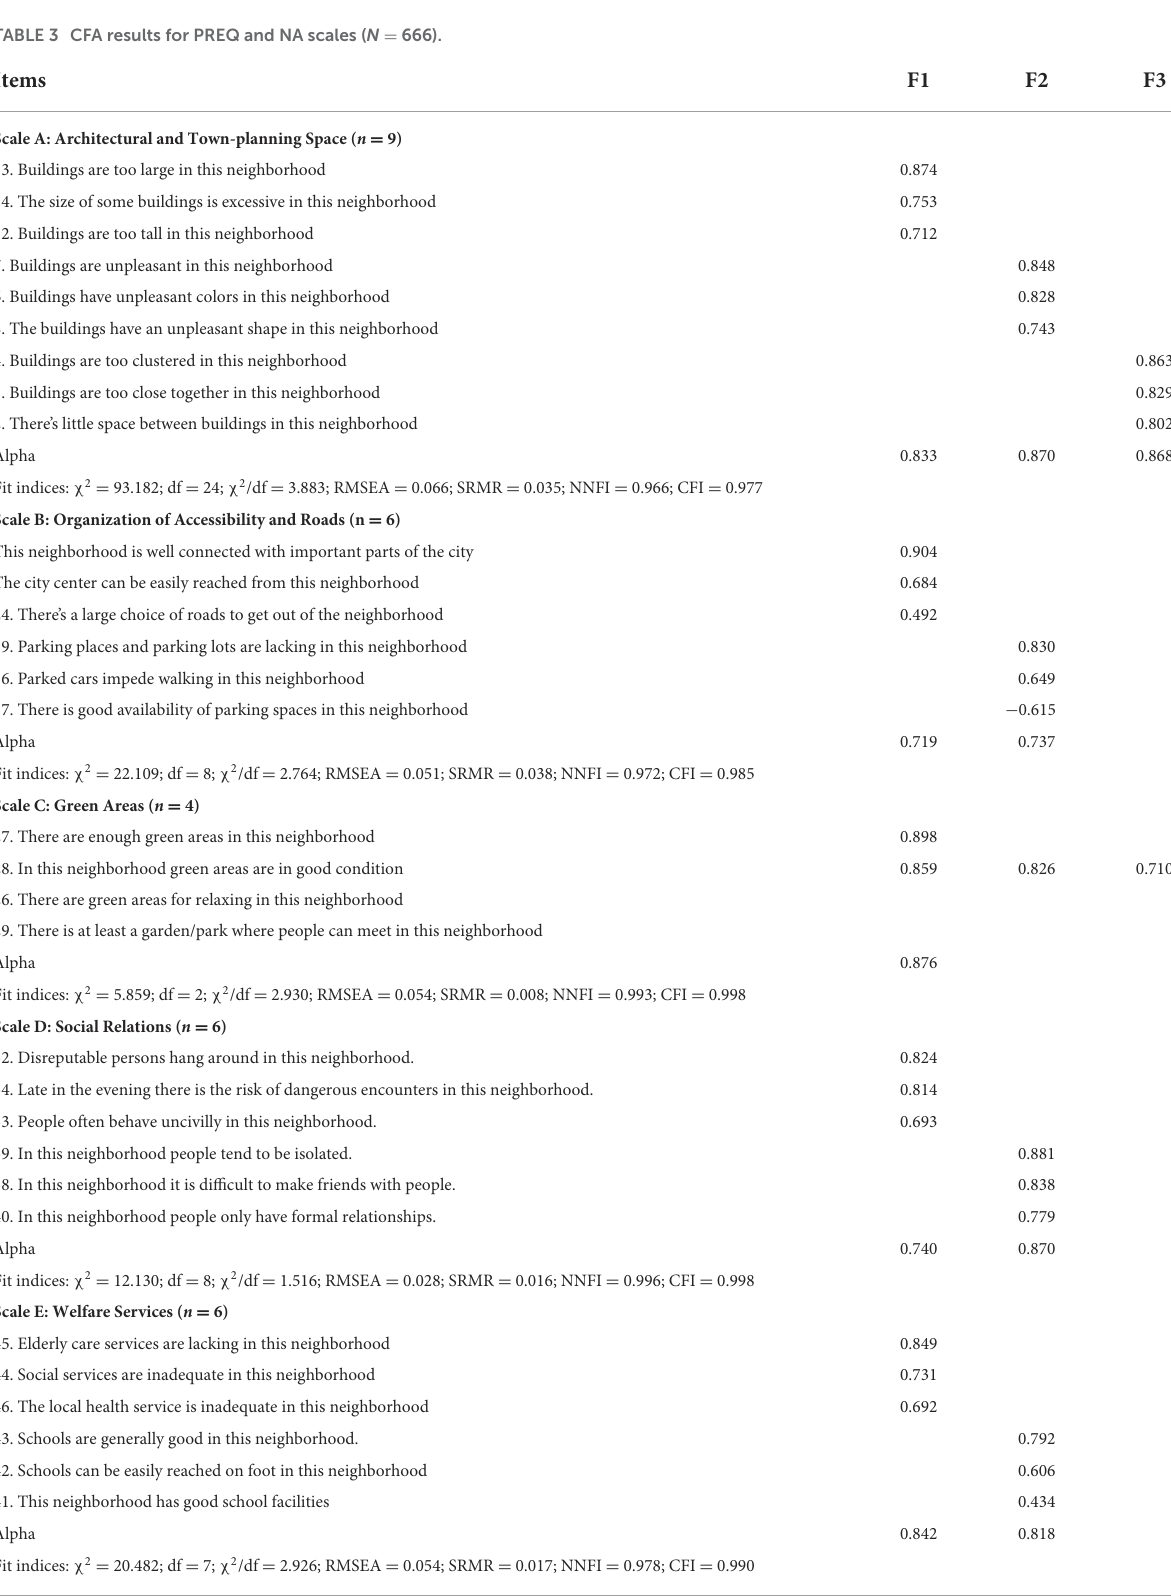
TABLE 3 CFA results for PREQ and NA scales ( N =